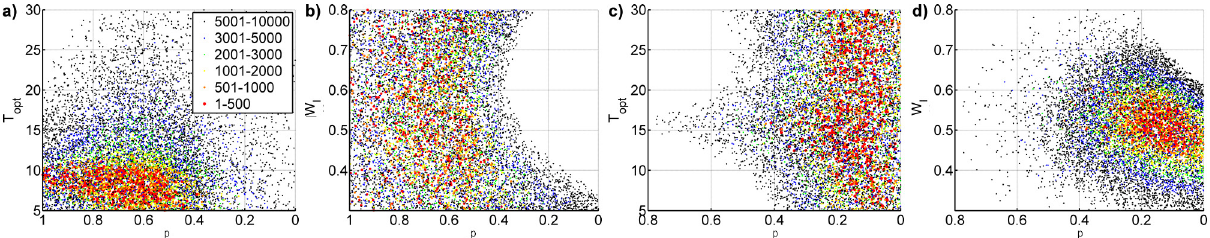
Fig. 10. The parameter space of p and T opt (a, c) and p and W I (b, d) resulting from Monte Carlo simulations (10000 best parameter sets according to the sum of squared errors (SSE) between measured and modelled F G -values out of 750000 runs) shows T opt being well defined if p is high (greater contribution of f T ) as shown for Wetzstein (a) and W I being better defined if p is low (greater contribution of f W ) such as at Lethbridge (d) . The same is true vice versa: W I is not well defined if f T has the greater contribution such as at Wetzstein (b) . and T opt is rather insensitive if f W dominates such as at Lethbridge (c) . The colors represent different classes with regard to the sorted SSE-values; the numbers refer to the ranking of the model results with regard to these